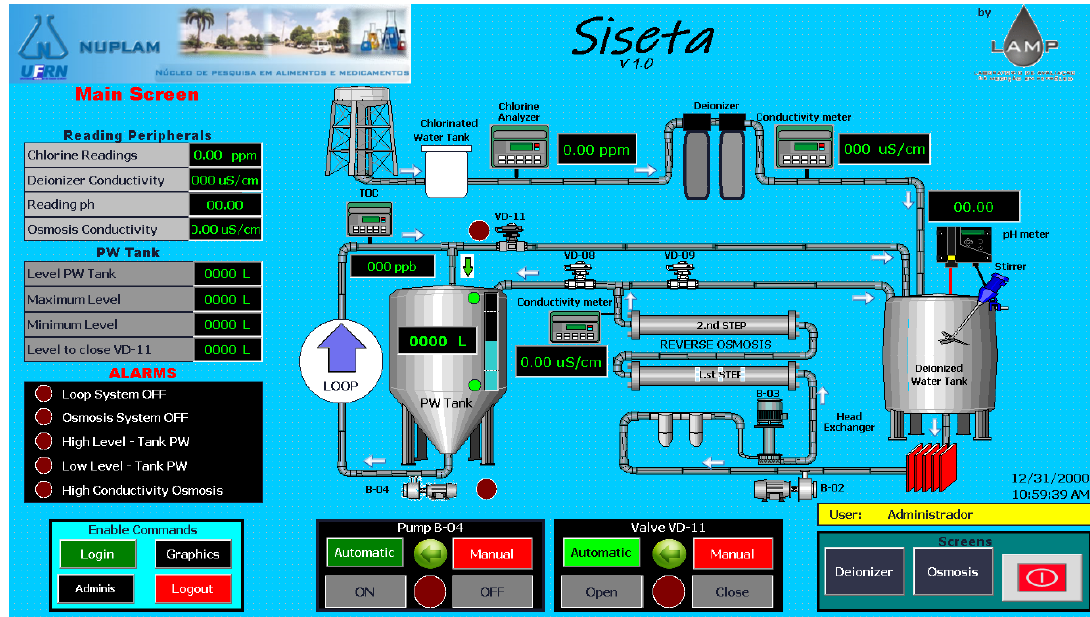
Figure 10. Main Screen of the Supervisory System